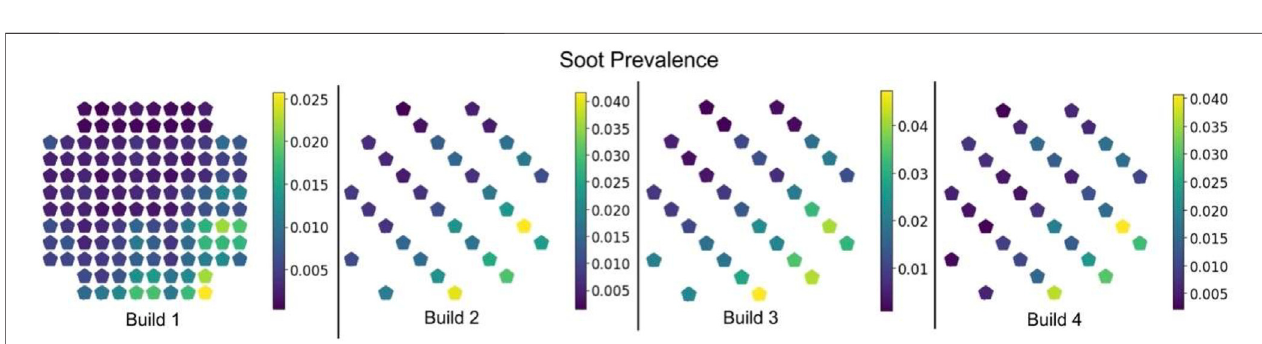
FIGURE 9 | Spatial distribution of soot prevalence for the four